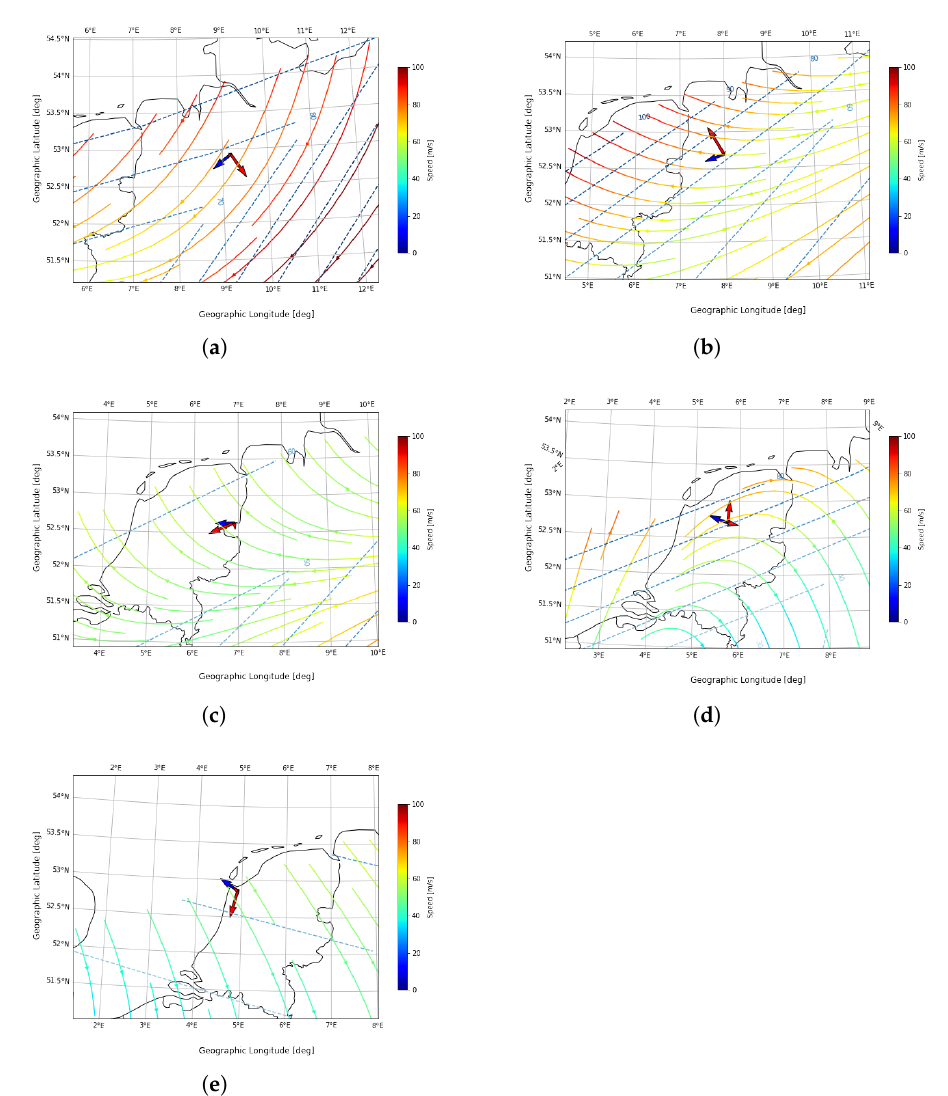
Figure 19. Spatial distribution of plasma drift velocity for the peaks 1-5 (panels ( a – e ), respectively) of L82655. Streamlines show plasma velocity vectors based on four digisondes (outside the map’s scope), blue lines: isolines of horizontal speed. Blue arrow: LOS propagation direction, red arrows: fitted directions of the disturbances based on 4 min central period wavelet coefficients, scaled by the percentage of explained